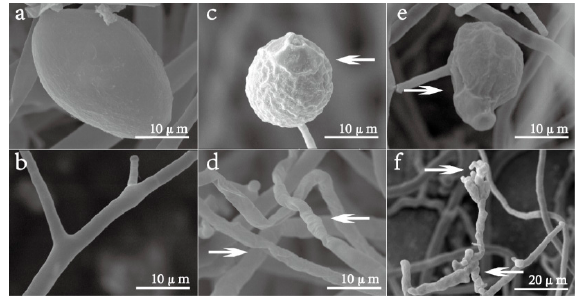
Figure 5. Effect of isoliquiritin on mycelium morphological changes of P. litchii Chen. ( a , b ): P. litchii Chen without isoliquiritin (control); ( c , d ): P. litchii Chen with isoliquiritin (40 mg/L); ( e , f ): P. litchii Chen with isoliquiritin (80 mg/L).